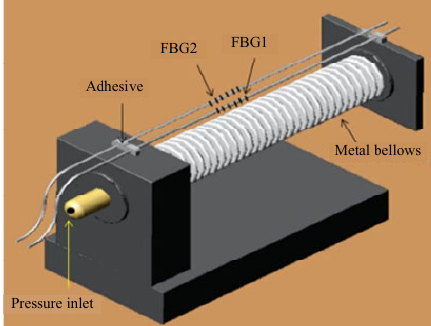
Fig. 16 Pressure sensor structure of the FBG.